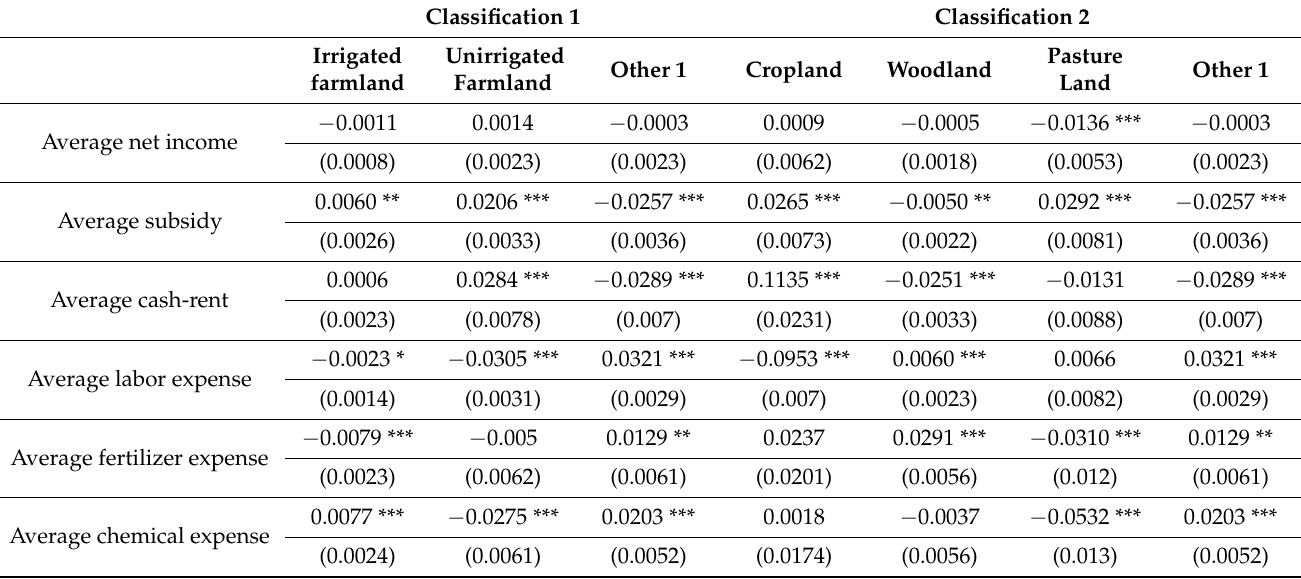
Table 7. Estimated Marginal Effects on Land-Use in Multinomial-Fractional-Logit Model with Lagged